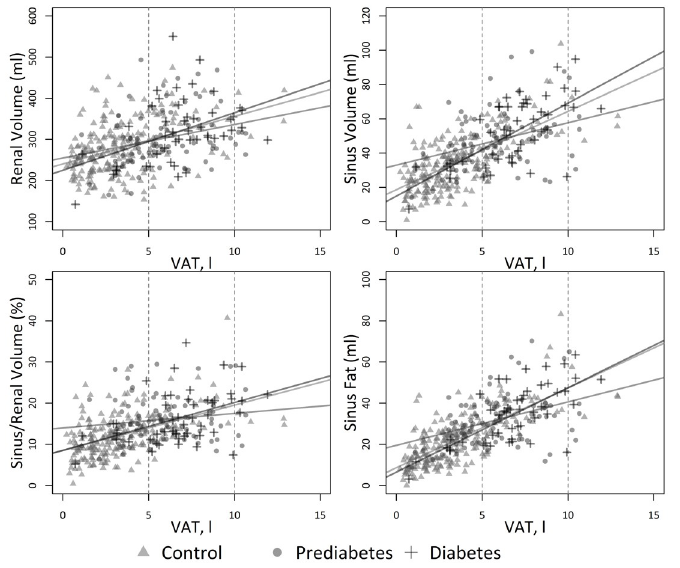
Fig 4. Scatter diagrams showing the correlation of the VAT with the glycemic groups. There was a significant correlation between VAT and renal sinus fat particularly for healthy controls and individuals with diabetes.